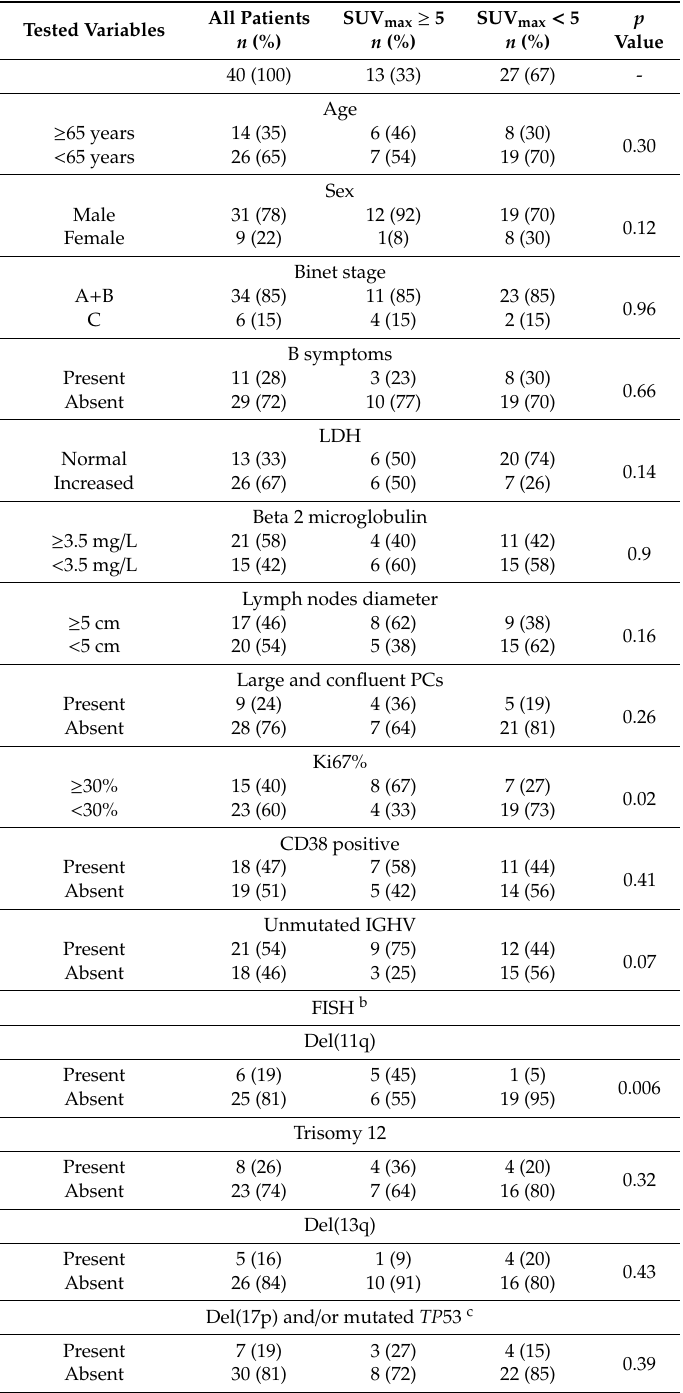
Table 1. Clinical and biologic characteristics of the patients with biopsy-proven chronic lymphocytic leukemia (CLL) according to the SUV max